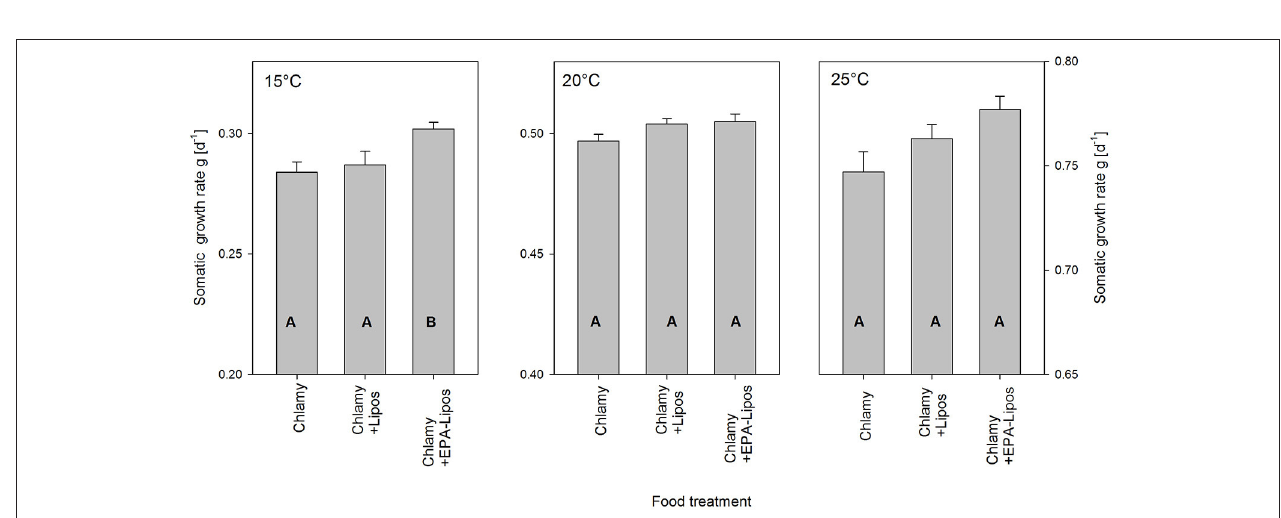
FIGURE 3 | Mean ( + SE, n = 3) juvenile somatic growth rates of D. magna grown at 15, 20, or 25 ◦ C. Daphnia was grown on the green alga Chlamydomonas klinobasis without supplementation (Chlamy) or with supplementation of liposomes (Chlamy + Lipos) or of EPA-containing liposomes (Chlamy + EPA-Lipos). C. klinobasis . was grown in continuous cultures at the same temperature as the temperature at which the respective Daphnia growth experiment was performed. Different letters indicate significant differences between treatments (Tukey’s HSD after one-way ANOVA) run at the same temperature. Note different